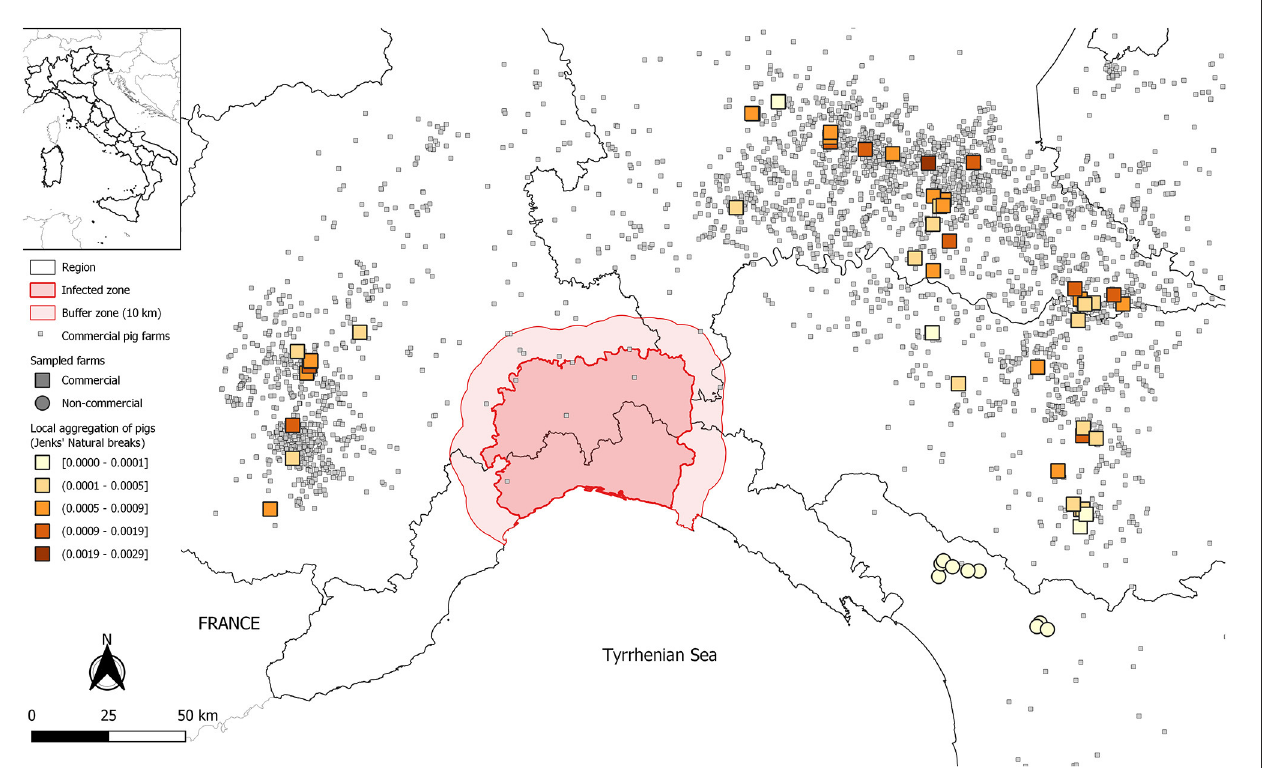
FIGURE6 Geographic distribution of commercial pig farms in Italy, and of 72 visited farms, which were classified by G statistics, as an index of local density of farmed pigs. Commercial farms are identified by squares. Non-commercial and small commercial farms in north western Tuscany are identified by circles. Farm location colour is based on Jenks natural breaks classification method, of all farm types combined. The infected area for ASF (4) is